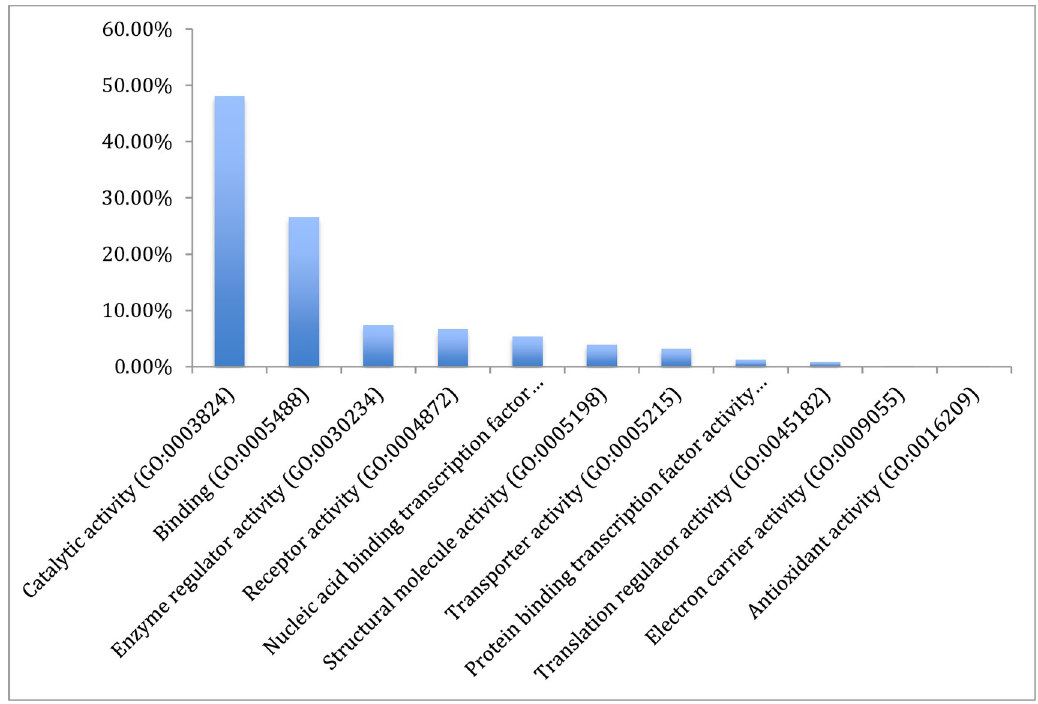
Fig 3. Gene ontology classification of the assembled transcripts of the Nile crocodile from the de novo transcriptome assembly showing the percentages of genes involved in various molecular functions.